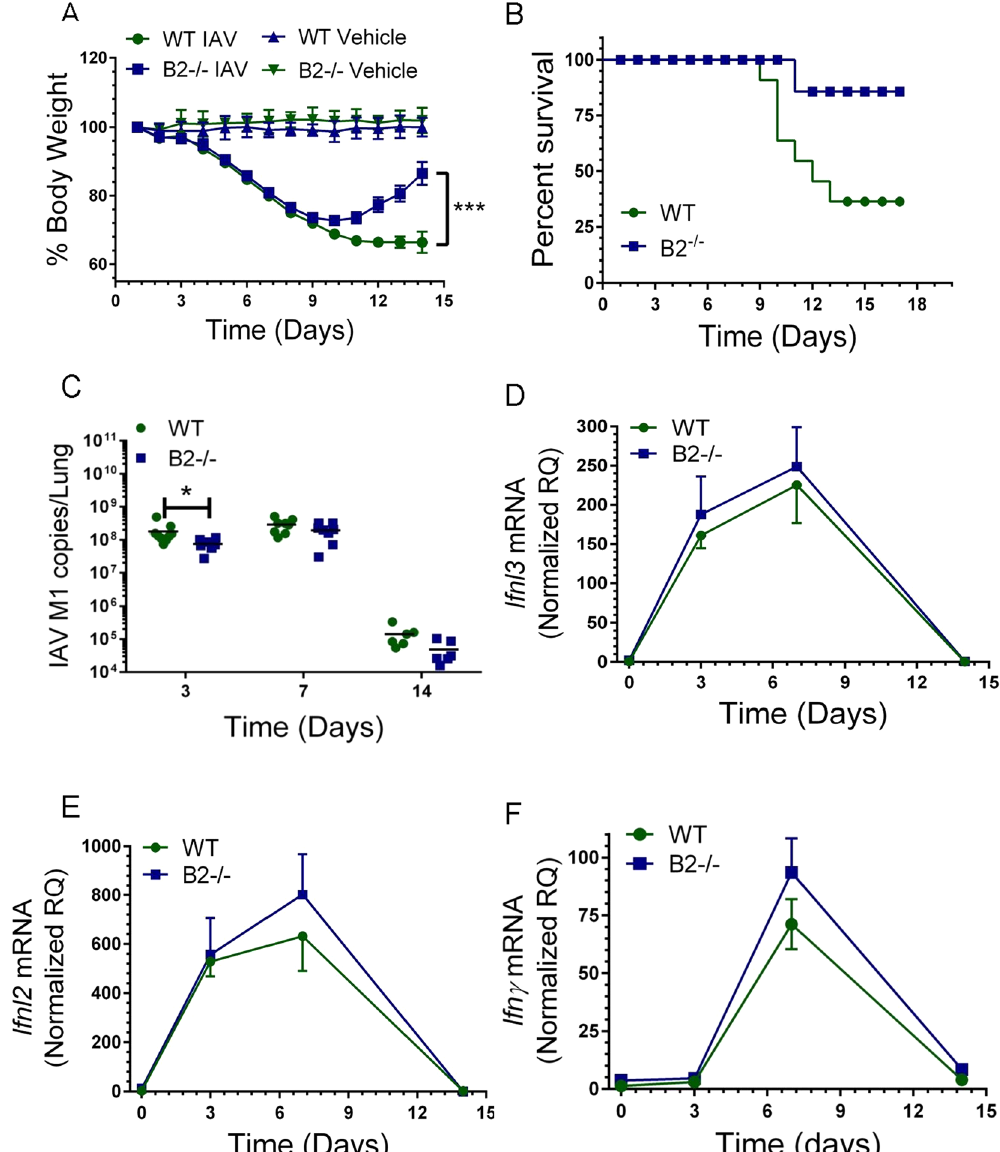
Figure 1. Endophilin B2 prevents recovery from severe influenza infection. Susceptibility and antiviral responses to influenza A virus (IAV) infection in WT and B2 − / − mice. WT and B2 − / − mice were infected with 1000 ffc of IAV H1N1 strain PR8 by intranasal administration. Uninfected WT and B2 − / − mice received DPBS vehicle. ( A ) Body weight was recorded daily over 14 days. N = 31 WT mice and n = 41, B2 − / − mice from 3 independent experiments. *** p < 0.0001 B2 compared to WT. ( B ) Kaplan-Meier survival curve of WT and B2 − / − mice. n = 19 WT mice and 17 B2 − / − mice from 2 independent experiments * p < 0.04 B2 − / − compared to WT. ( C ) The viral titers were determined as the number of IAV M1 RNA copies in total lung. * p < 0.03 at t = 3 days for WT compared to B2 − / − mice (for WT n = 9, 8, and 6 and B2 − / − n = 7, 8, and 6 at t = 3, 7, and 14 days). ( D–F ) Expression of Ifnl2 ( D ), Ifnl3 ( E ), and Ifng ( F ) were quantitated by qRT-PCR in total lung. Data were normalized to 18 S rRNA and expressed relative to mRNA from WT uninfected control treated with DPBS vehicle (for WT n = 4, 9, 8, and 6 and B2 − / − n = 3, 7, 8, and 6 mice at t = 0, 3, 7, and 14 days, respectively; the vehicle treated mice are plotted as t =